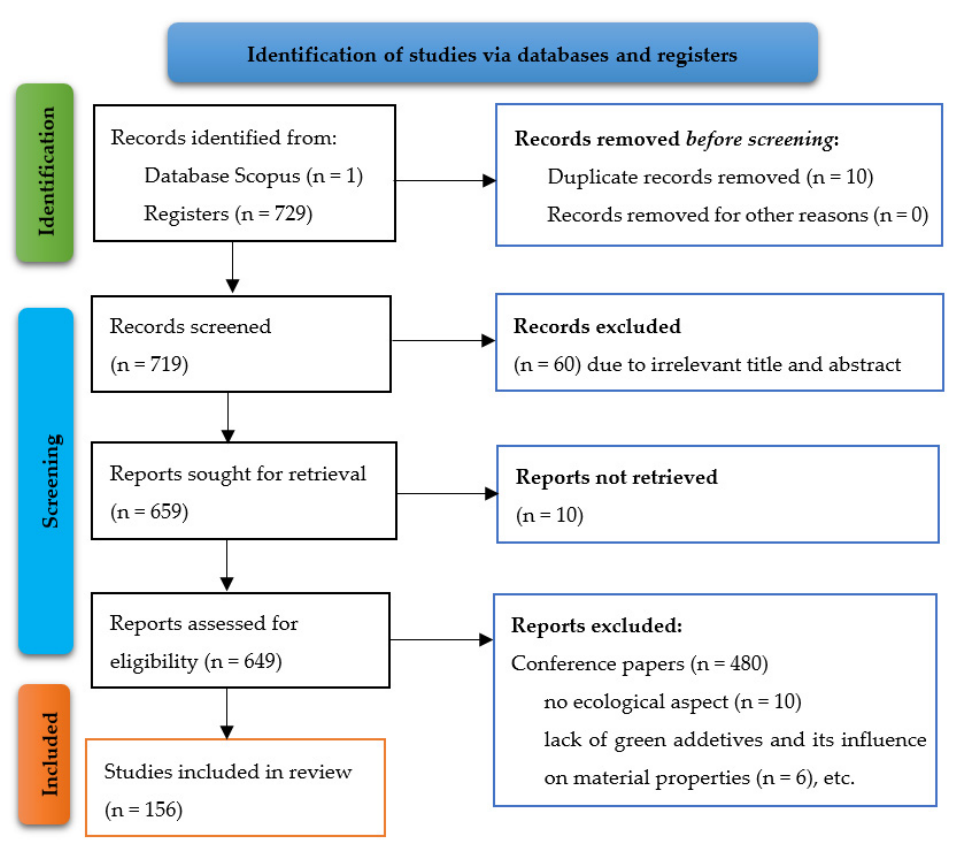
Figure 2. Literature search flowchart.